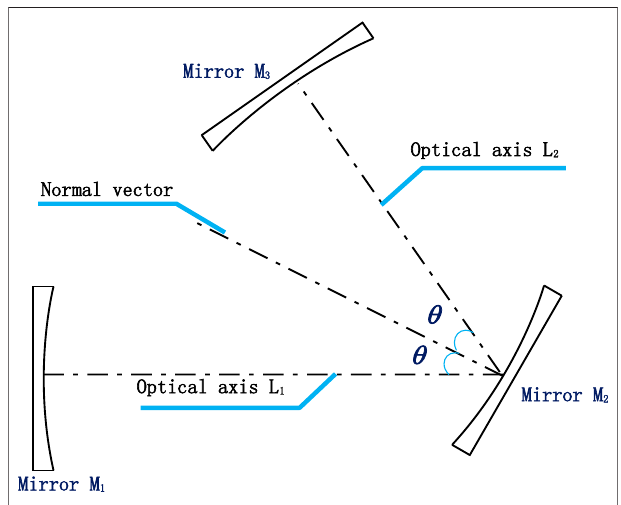
FIGURE 1 | Transmission of the rays in the folded MPC consisting of three mirrors M 1 , M 2, and M 3 ; the re fl ection on the M 2 , M 3 surface in the x – z plane of a Cartesian coordinate system; R radius of the curvature of the spherical mirror; L 1 L 2 , mirror distance; θ inclination angle of the mirror M 2